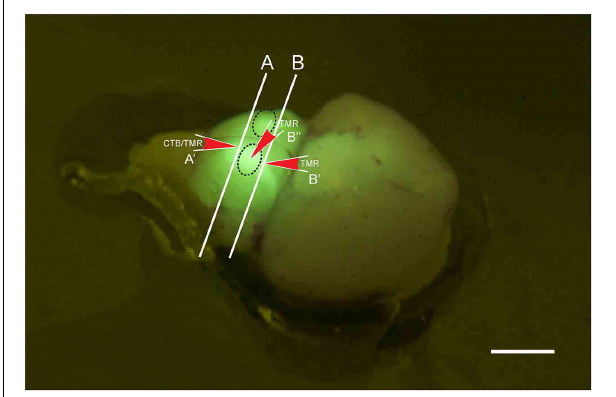
FIGURE 1 | Photo of a brain stem explant of a young (p2) GlyT2-GFP mouse showing the ”bulbs” on the ventral surface of the explant (dashed oval lines). The image was taken through a yellow filter while the brain explant was illuminated with a 405nm laser. With this type of lighting, the bulbs light up brightly and can easily be distinguished, presumably because they contain the VNTB with GFP positive neurons close to the brain surface, and presumably because other major sources of GlyT2-GFP label, such as the MNTB, are located close by. The locations of the two different coronal cutting planes for retrograde and anterograde injections are shown by lines A and B, respectively, and the injection sites and their directionality are depicted by the red arrows A’, B’, and B.” Scale bar: